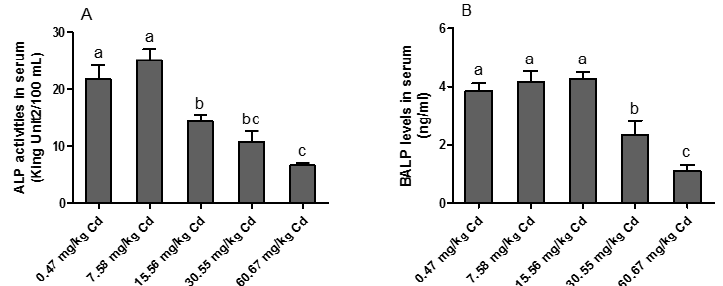
Figure 2. Effects of Cd on the activity of alkaline phosphatase (ALP) and the level of bone ALP (BALP) in the serum of laying hens. ( A ) ALP activity in the serum; ( B ) BALP level in the serum. Values are presented as the mean ± SE ( n = 8). a–c Means with different superscript letters are significantly different ( p < 0.05).